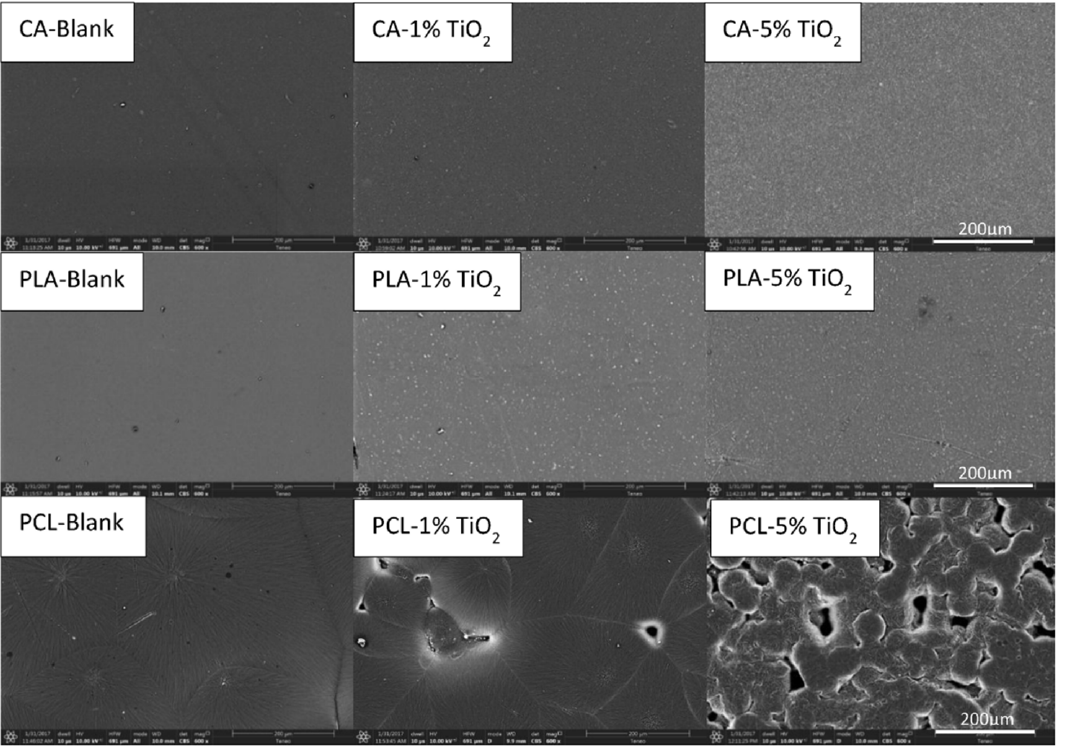
Figure 9. SEM images of TiO 2 NPs embedded PLA, PCL and CA polymeric films. Reprinted from Reference [3].